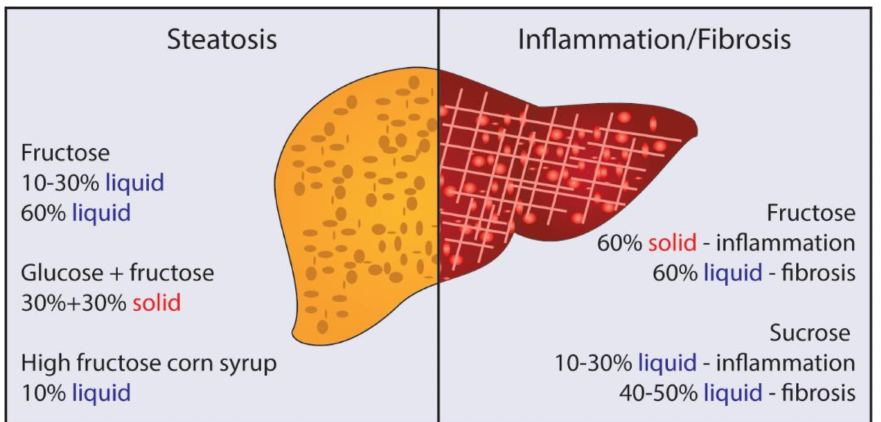
Figure 1. Dietary sugars promoting either hepatic steatosis or inflammation and fibrosis. Steatosis can be induced by liquid fructose (10–30% w / v ) or by a mixture of glucose and fructose (30% + 30% w/w solid, or 10% w / v high-fructose corn syrup in water) alone or in combination with high-fat content. 60% liquid fructose induces both steatosis and fibrosis, while 60% solid fructose promotes hepatic inflammation. Liquid sucrose (10–30% w / v ), with or without high fat, stimulates hepatic inflammation, with higher doses (40–50% w / v ) promoting